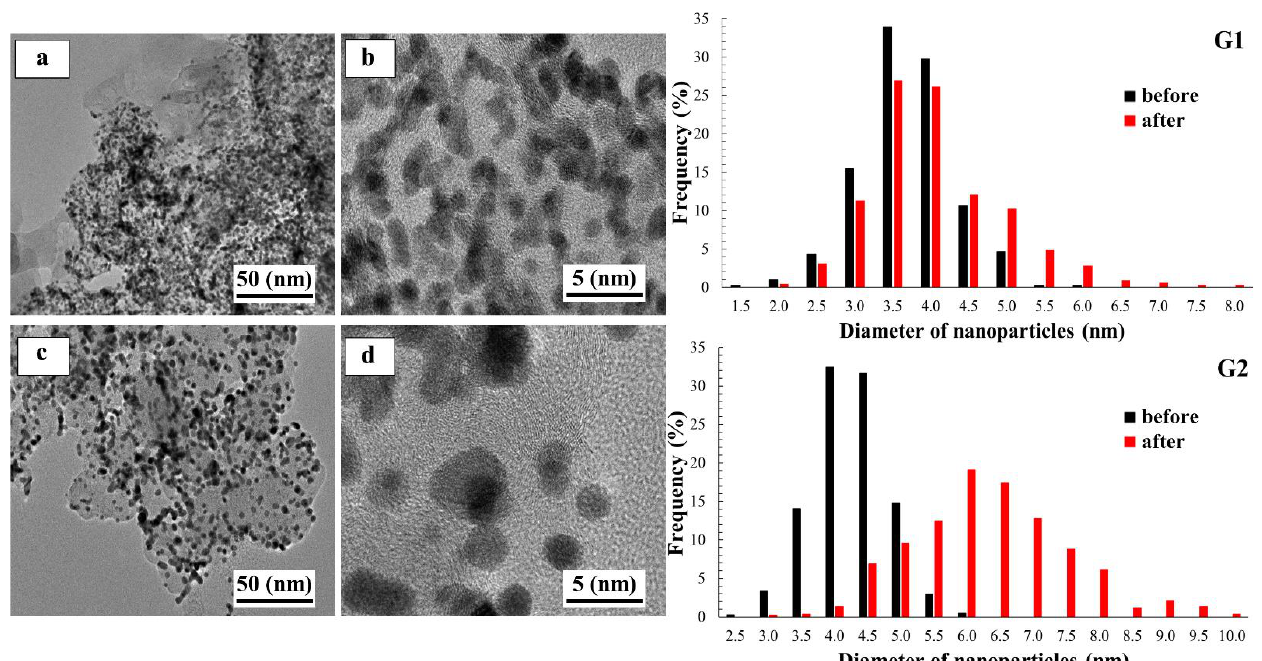
Figure 10. TEM micrographs of Pt/C catalysts after ADT at the potentials of 0.4 and 1.4: ( а , b ) G1and ( c , d ) G2, and histograms of the NP size distribution before and after ADT in the corresponding materials.